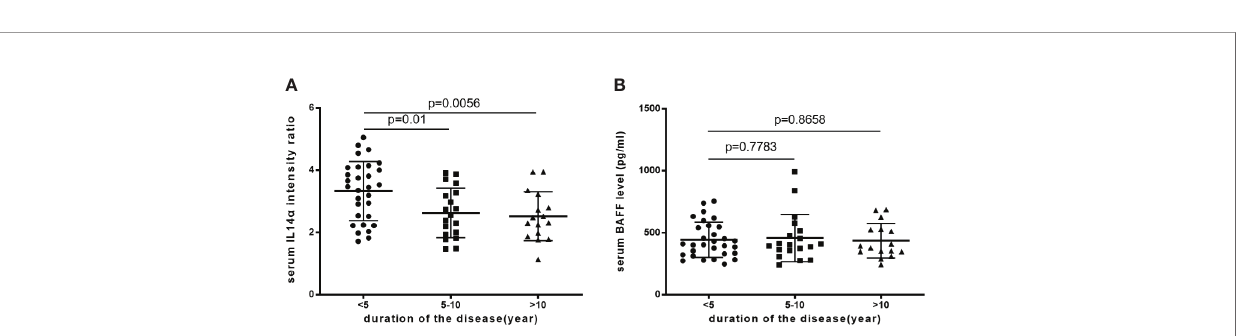
FIGURE 3 | (A) The mean serum IL-14 a levels with disease duration. (B) The mean serum BAFF levels with disease